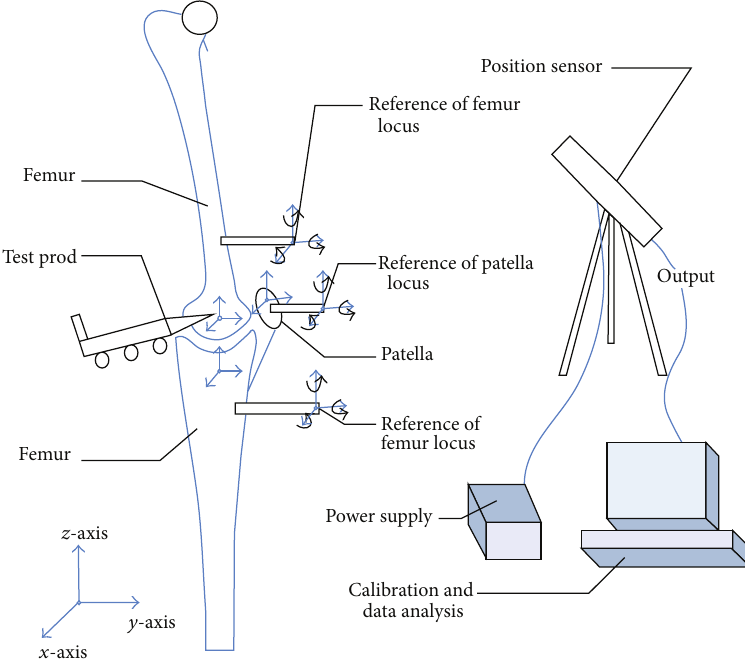
Figure 5: The measurement system of movement.